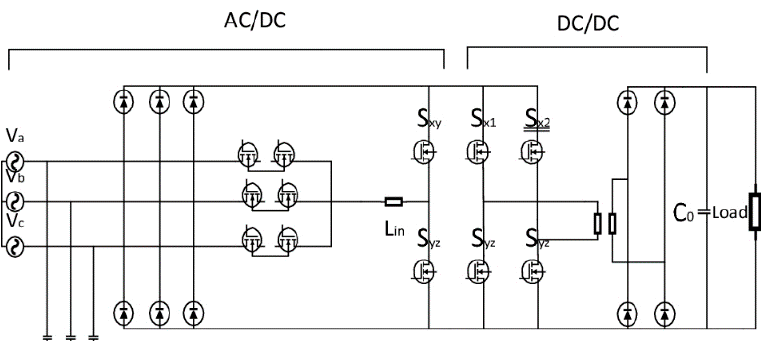
Figure 6. Matrix Converter [37].